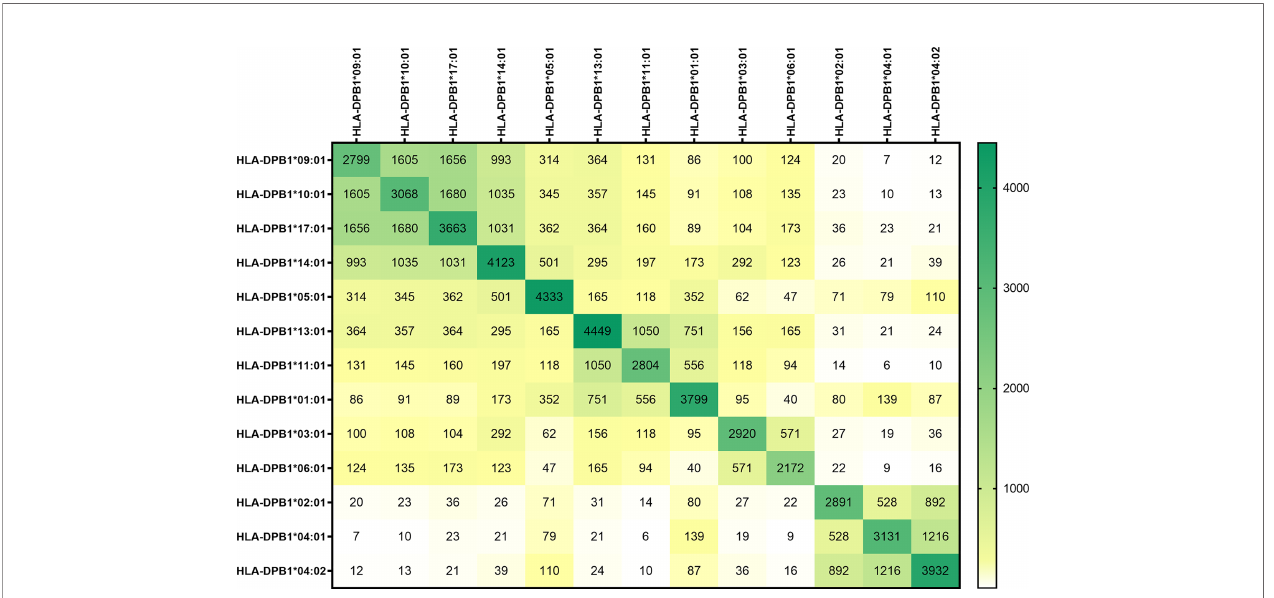
FIGURE 1 | The overlap in peptide sequences presented by the HLA-DP molecules. The peptide sequences presented in the most frequently expressed HLA-DP molecules were unraveled using immunoaf fi nity chromatography and mass spectrometry. The peptides were quanti fi ed, including the length variants, using peptide- to-sequence matching. The absolute number of peptides shared between the HLA-DP molecules are demonstrated. In the dark green boxes at the diagonal, the total number of sequences per HLA-DP molecule are depicted. The numbers of peptides shared between different HLA-DP molecules and the level of overlap in presented peptides is illustrated by the numbers in the heatmap and by coloring of the boxes, with white to yellow indicating no/limited overlap and green indicating relatively abundant